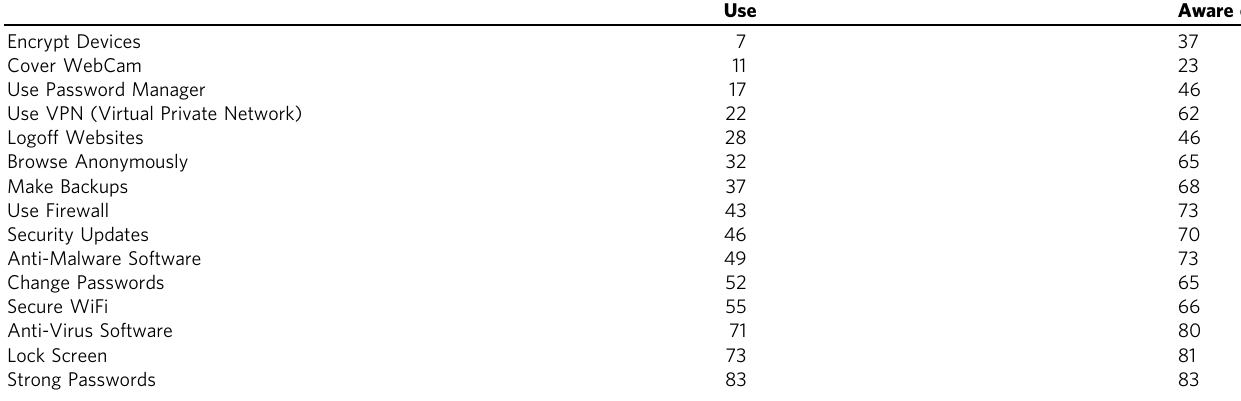
Table 2 Frings words (Frings et al., 2010).